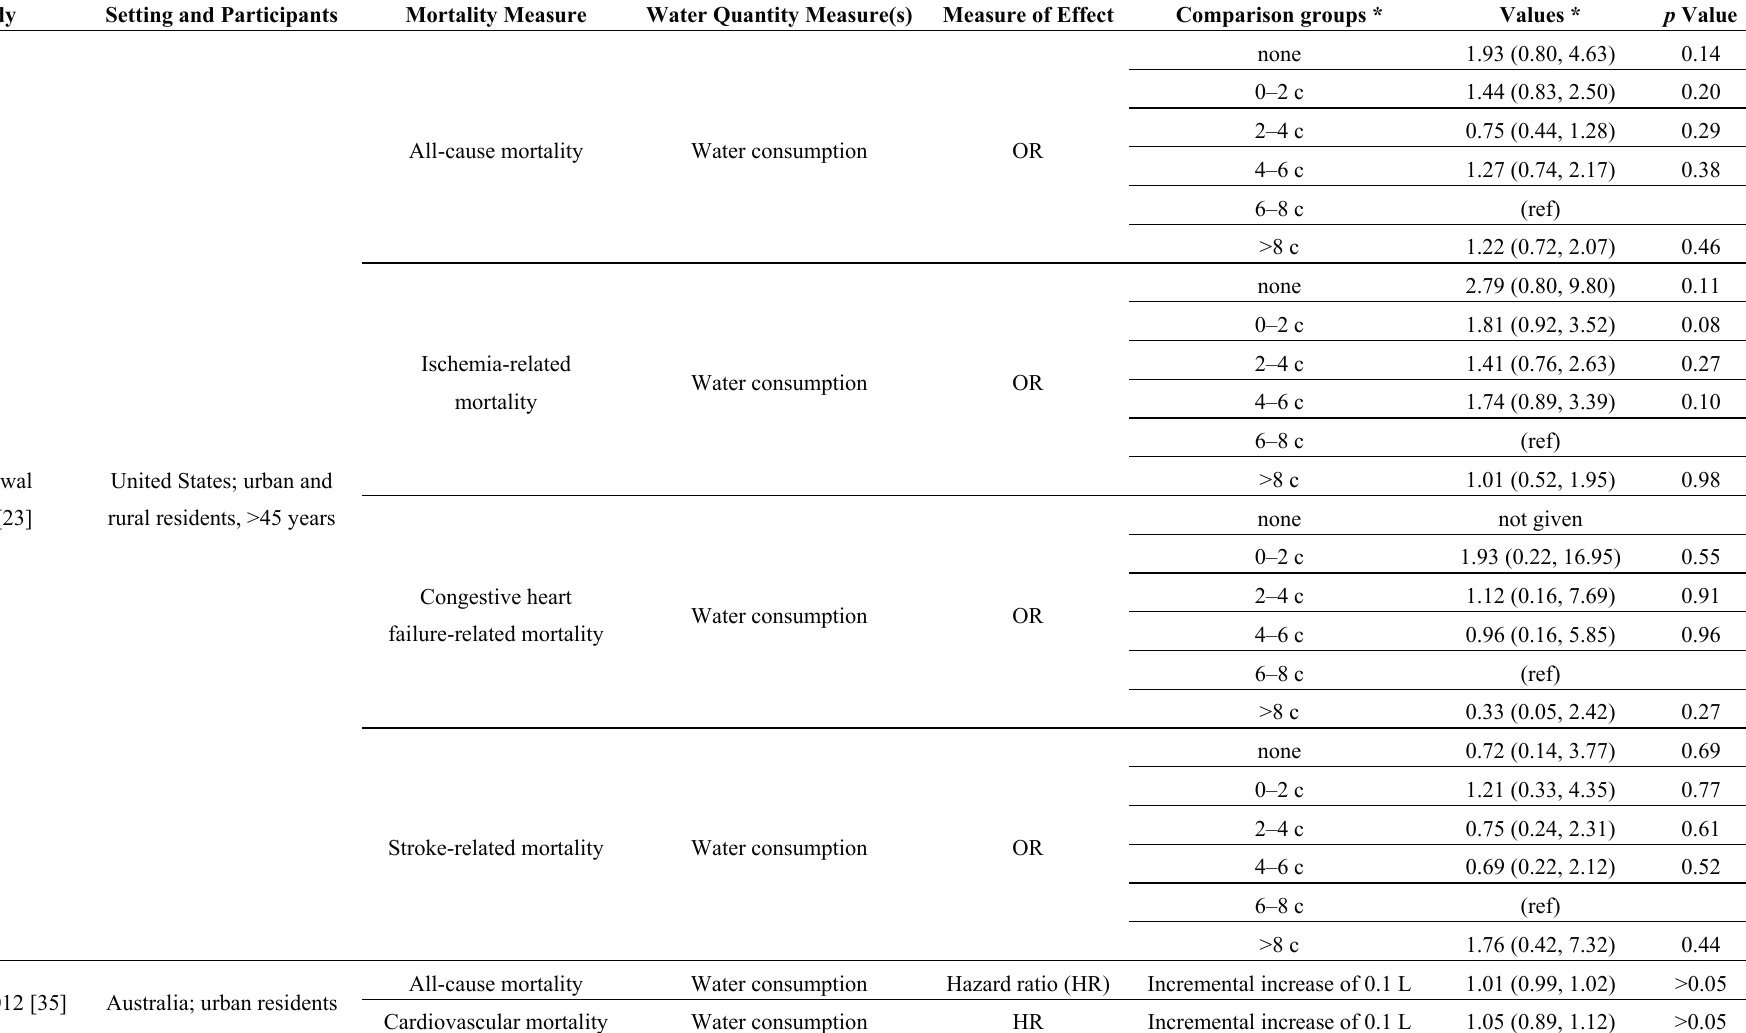
Table 6. Effects of Water Quantity on